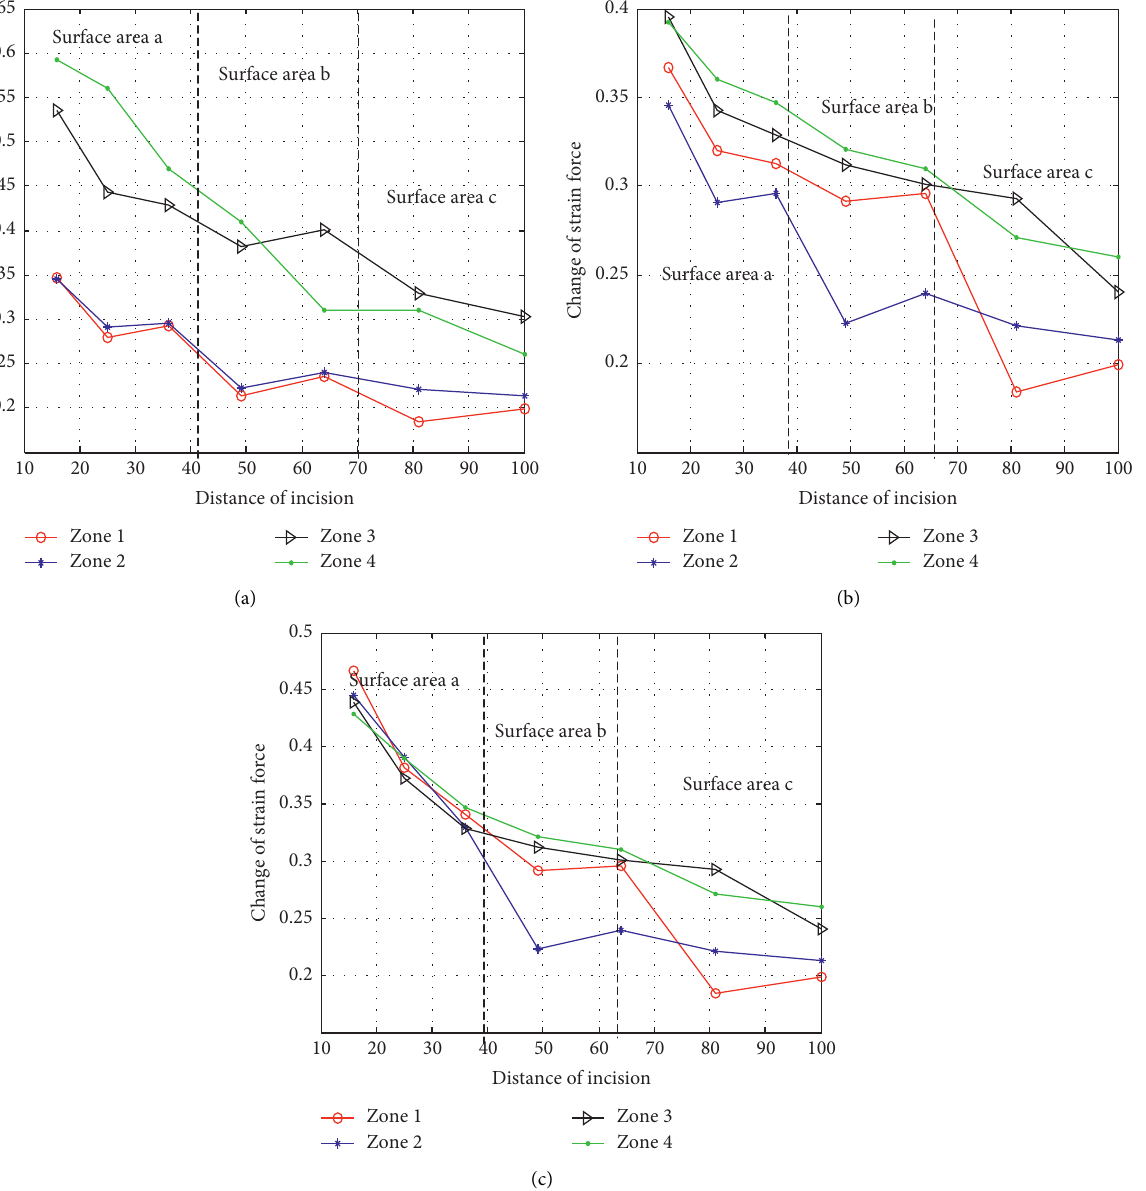
Figure 6: Variation curve of surface deformation corresponding to different heights of crack zone on site surface (30cm). (a) Division 1. (b) Division 2. (c) Division